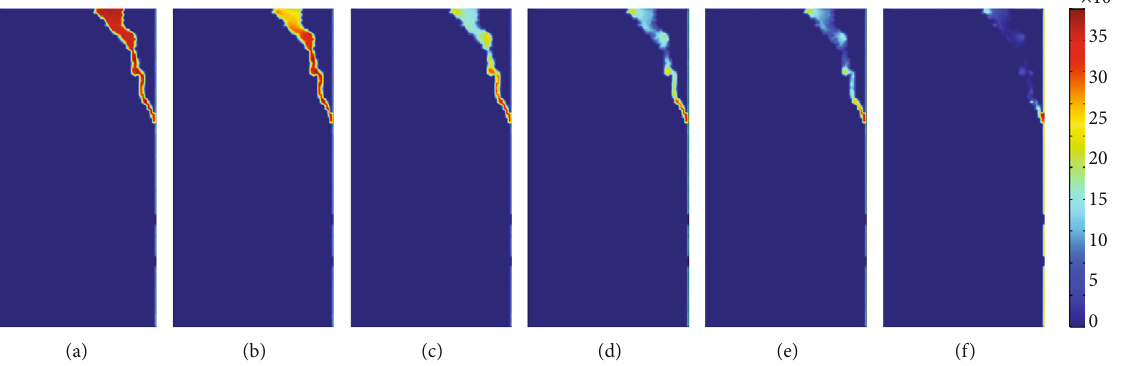
Figure 14: Cloud map of variation of permeability distribution with time (coal sample 2#). (a) t = 1 s . (b) 10s. (c) 50 s. (d) 100 s. (e) 200s. (f) 2000s.